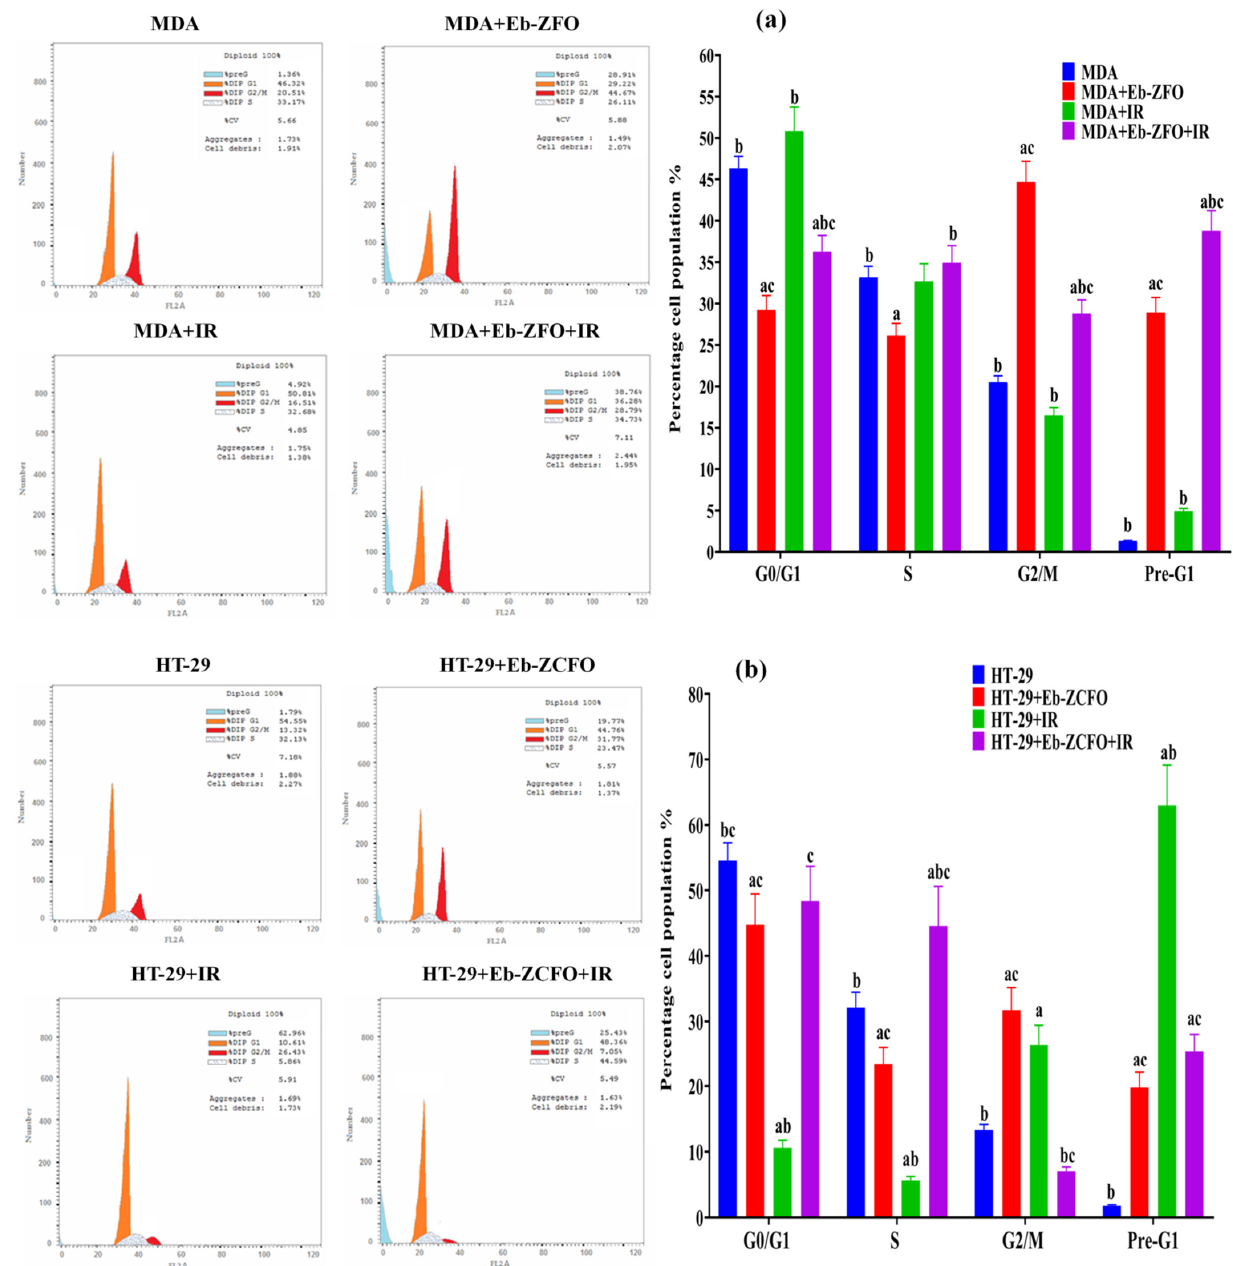
Figure 19. Cell-cycle analysis via flow cytometry. ( a ) Distribution of MDA-MB-231cells through the cell-cycle phases after treatment with Eb-ZFO alone or in combination with 4 Gy γ -radiation for 24 h. MDA group: untreated MDA-MB-231 cells served as control. MDA + Eb-ZFO group: MDA-MB-231 cells treated with Ebselen (Eb) doped intoZnFe 2 O 4 nanoparticles (ZFO). MDA + IR group: MDA-MB-231 cells exposed to γ -radiation. MDA + Eb-ZCFO + IR group: MDA-MB-231 cells treated with Eb-ZFO and exposed to IR. ( b ) Distribution of HT-29 cells through the cell-cycle phases after treatment with Eb-ZCFO alone or in combination with 4 Gy γ -radiation for 24 h. HT-29 group: untreated HT-29 cells served as control. HT-29 + Eb-ZCFO group: HT-29 cells treated with Ebselen (Eb) and ZnCe 0.06 Fe 1.94 O 4 nanoparticles (ZCFO). HT-29 + IR group: HT-29 cells exposed to γ -radiation. HT-29 + Eb-ZCFO + IR group: HT-29 cells treated with Eb-ZCFO and exposed to IR. Results are expressed as the mean and standard error of the mean (SEM) (n = 3). Columns with a, b, and c letters overhead within the same phase are significantly different from the control, treated group, or IR group of each cell line, respectively, at p <